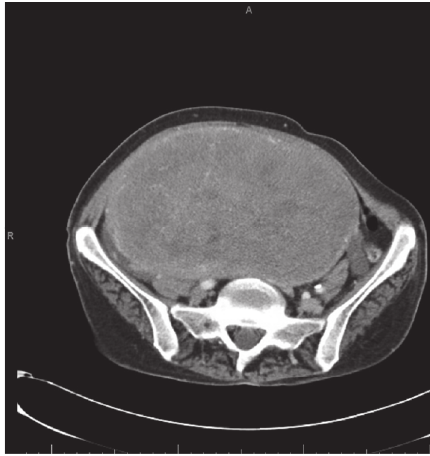
Figure 4: Abdomen-pelvis CT scan of case 2 showing large uterine